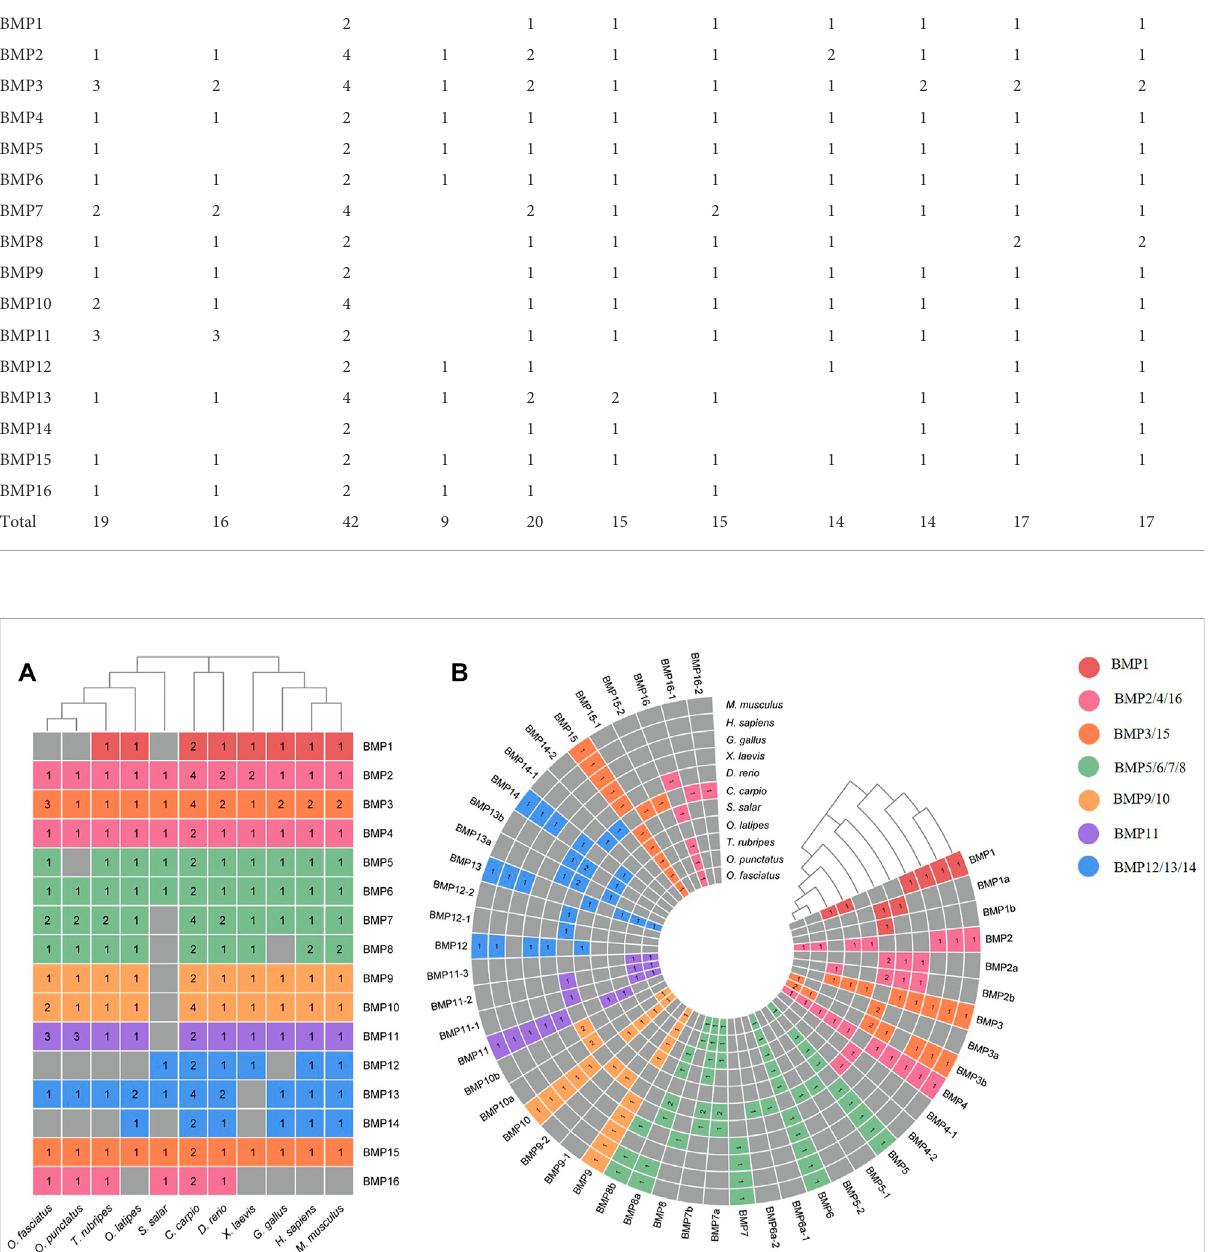
Figure 8C, members of the BMP11 subfamily were mainly expressed in the gill. Additionally, BMP11-1 was also highly expressed in the intestine and the surrounding tissues of the